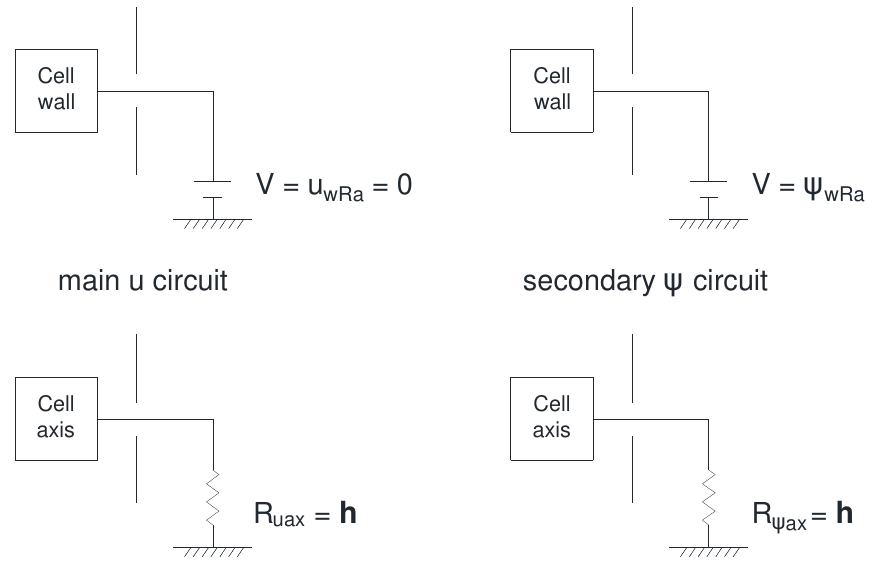
Figure 6. Elements associated with the boundary conditions in radial domains.